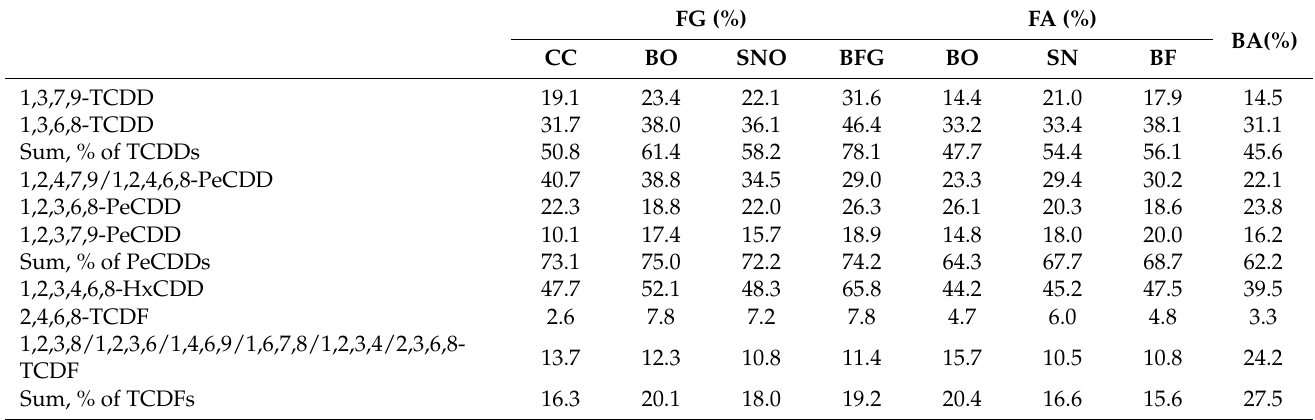
Table 3. Relative importance of CP-route congeners in FG and FA/BA in leather waste